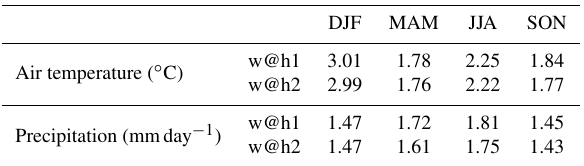
Table 1. Global root mean squared biases by season for